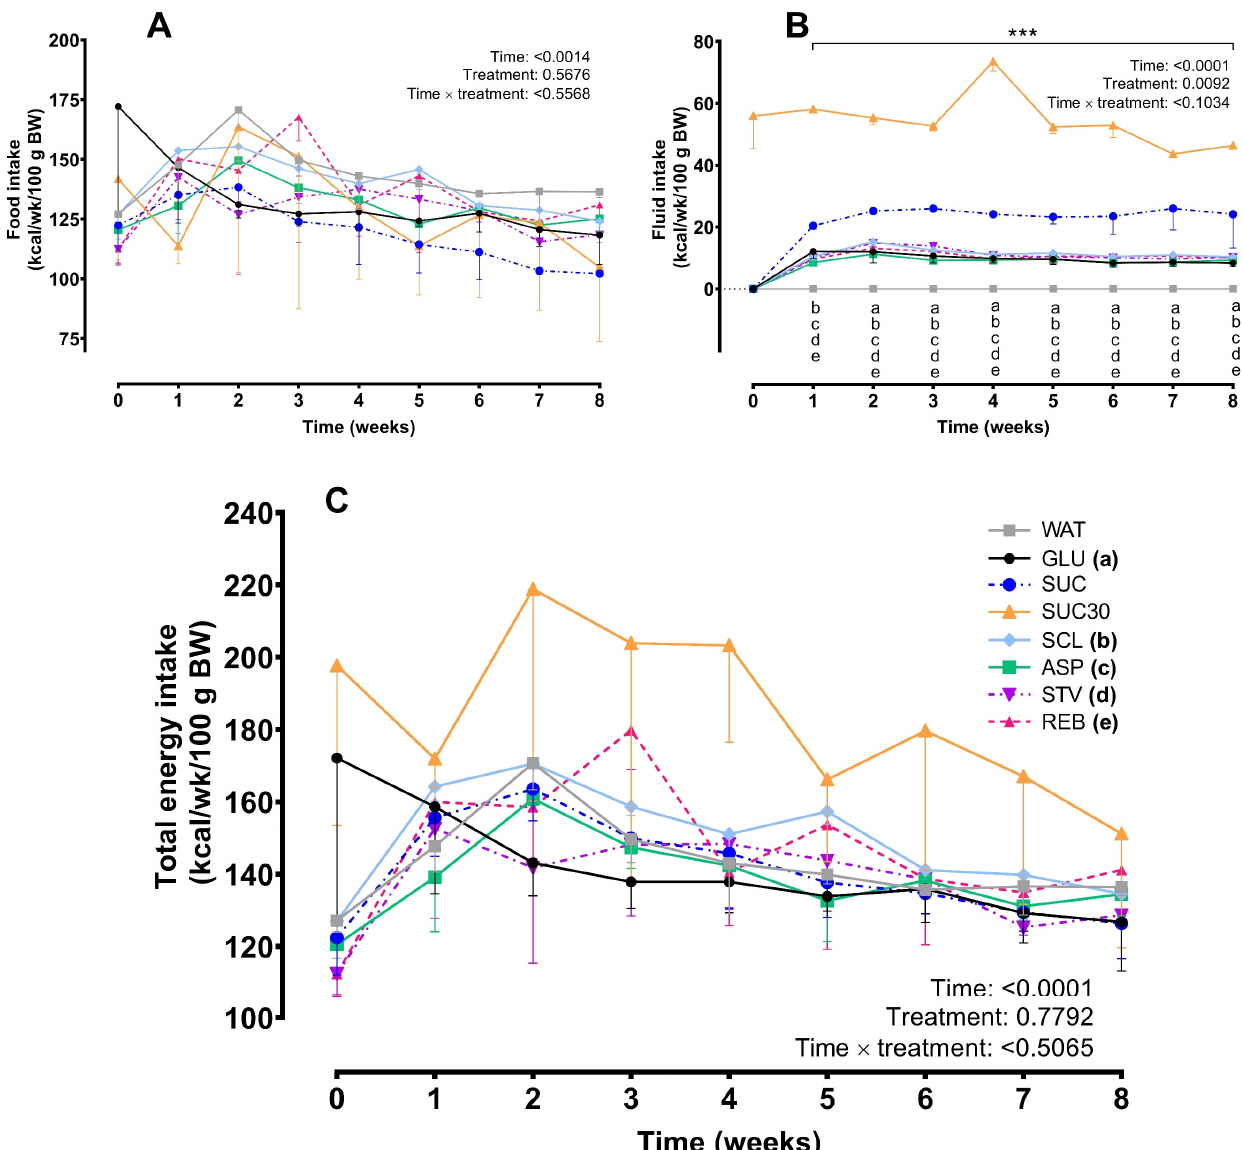
Figure 4. Effects of NNS on food intake ( A ), fluid intake ( B ), and total energy intake ( C ) in the HFD group throughout 8 weeks of treatment (phase 2). Data are expressed as mean ± SEM. ( n = 6–8 animals per group). Two-way RM ANOVA followed by Tukey’s post hoc test was used. Asterisks indicate significant differences in the 30% sucrose-treated group (SUC30) vs. each other group at *** p < 0.0001. Different lowercase letters in each time point indicate significant differences in the sucrose group (SUC) vs. each other group: (a) GLU, glucose; (b) SCL, sucralose; (c) ASP, aspartame; (d) STV, stevia; (e) REB, reb A ( p < 0.05). Fluid in the water-treated group (WAT) did not contribute calories.